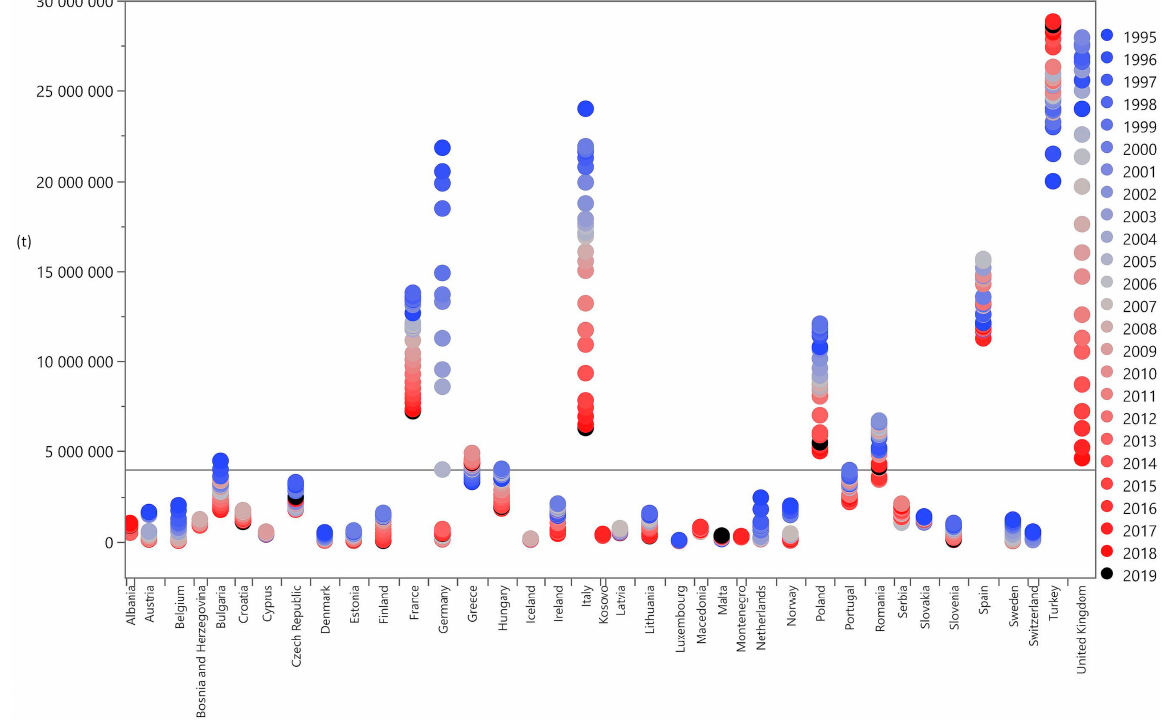
Figure 8. Municipal waste production in the EU with production of up to 13 million tons per year.